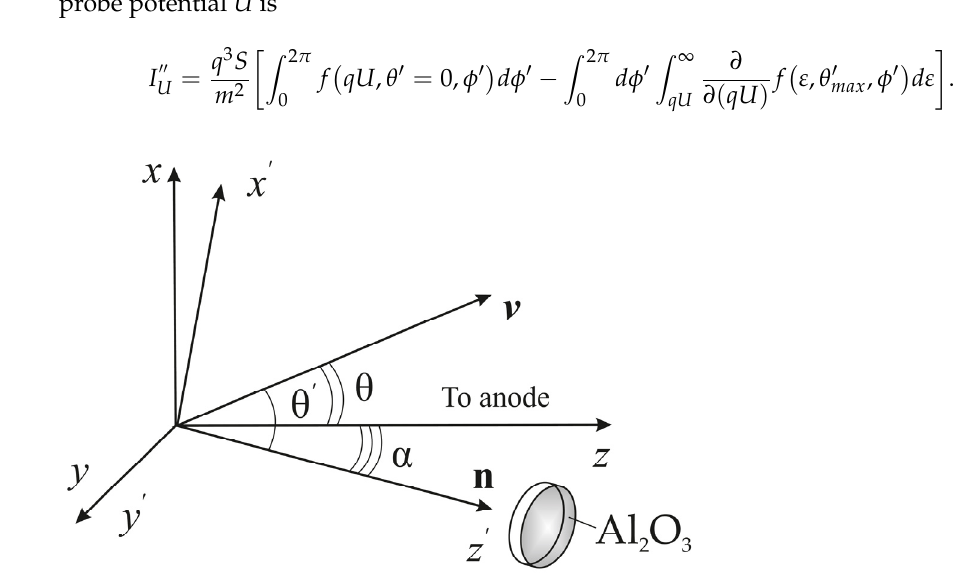
Figure 2. Orientation of the probe in the plasma (here, θ is the polar angle of the EVDF in x - y - z coordinate system, 𝜃 (cid:4593) is the polar angle of the vector 𝑣⃗ in x’ - y’ - z ’ system, and α is the angle be- tween the normal to the probe surface and the plasma symmetry axis.